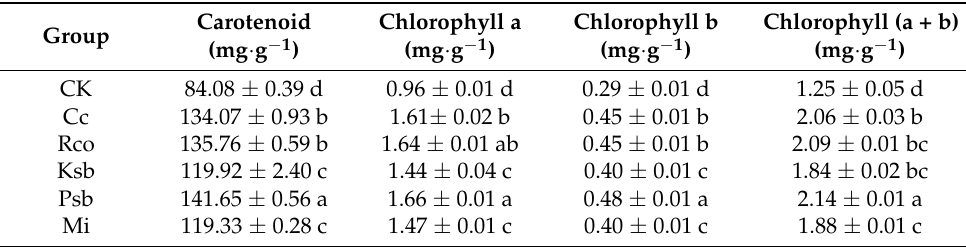
The values are means ± standard deviation of 5 plants randomly selected from each treatment. Different lowercase letters in a column indicate significant differences based on Tukey’s test ( p < 0.05). Cc: Claroideoglomus claroideum Table 1. Effects of different microbial inocula on the photosynthetic pigment content of the F. tai- treatment group, about 1360 C. claroideum spores for each container; Rco: Racocetra coralloidea treatment group, paiensis leaves (fresh weight). about 1430 R. coralloidea spores for each container; Ksb: potassium solubilizing bacteria treatment group, 35 g Bacillus mucilaginosus inoculum for each container; Psb: phosphorus solubilizing bacteria treatment group, 35 g Bacillus megaterium inoculum for each container; Mi: mixed treatment group with mixed inoculum of C. claroideum , R. coralloidea , B. mucilaginosus , and B. megaterium , the application amount of each microbial inoculum was 1/4 of the former 4 groups; CK: control group, no microbial inocula were